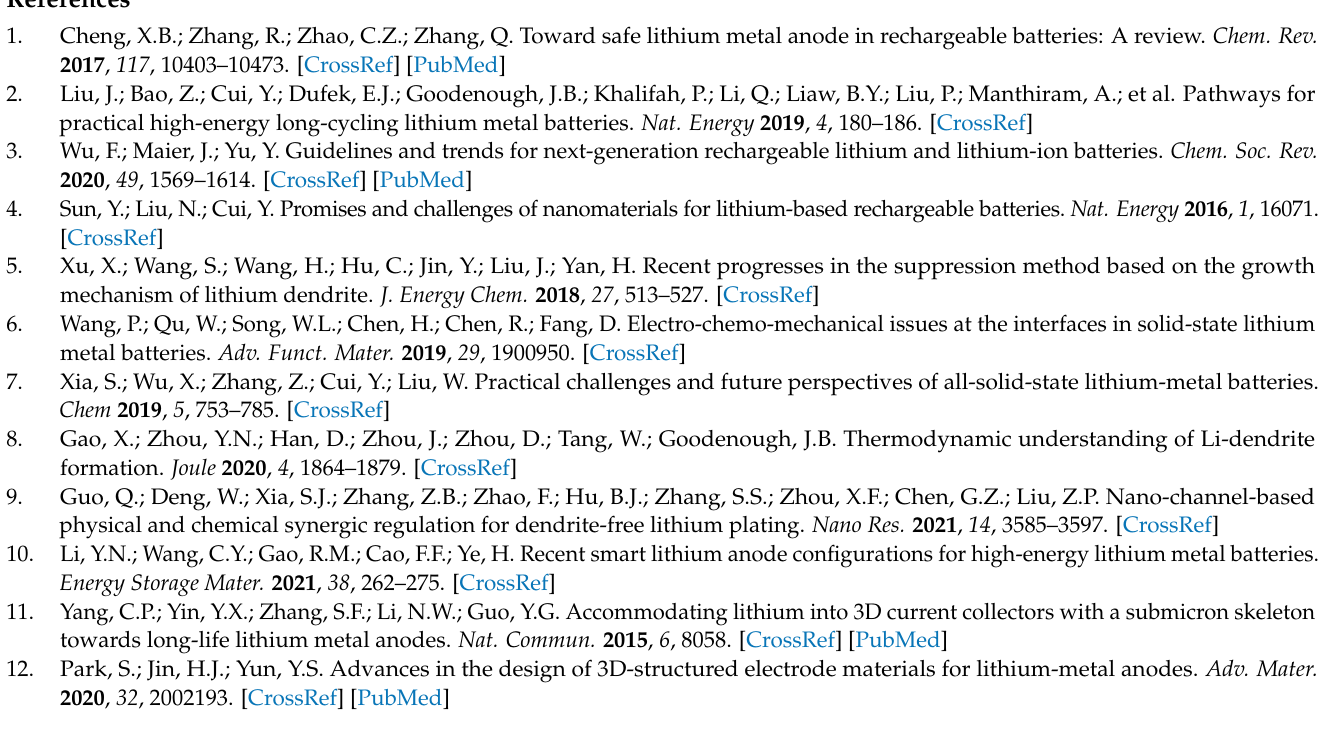
separators; Table S1: The physical and eletrochemical properties of separators; Figure S3: Optical photographs after pouring electrolyte onto different separators; Figure S4: Tensile strength test of different separators; Figure S5: Chronoamperometry profiles and Nyquist plots for symmetric cells with PP and PAN separators; Figure S6: SEM images of PAN separator disassembled from Li/PAN/Cu half cells; Figure S7: SEM morphology of Li deposited with ZIF8-PAN separator at different current densities; Figure S8: Initial discharge CV curves of cells assembled with certain separators; Figure S9: CE of Li//Cu half cells with PAN separator; Figure S10: Cyclic stability of symmetric cells assembled with PAN and ZIF8-PAN separators; Figure S11: Cyclic performance of full cell assembled with PAN; Figure S12: SEM analysis of pristine and cycled LiFePO4 electrodes using PP and ZIF8-PAN